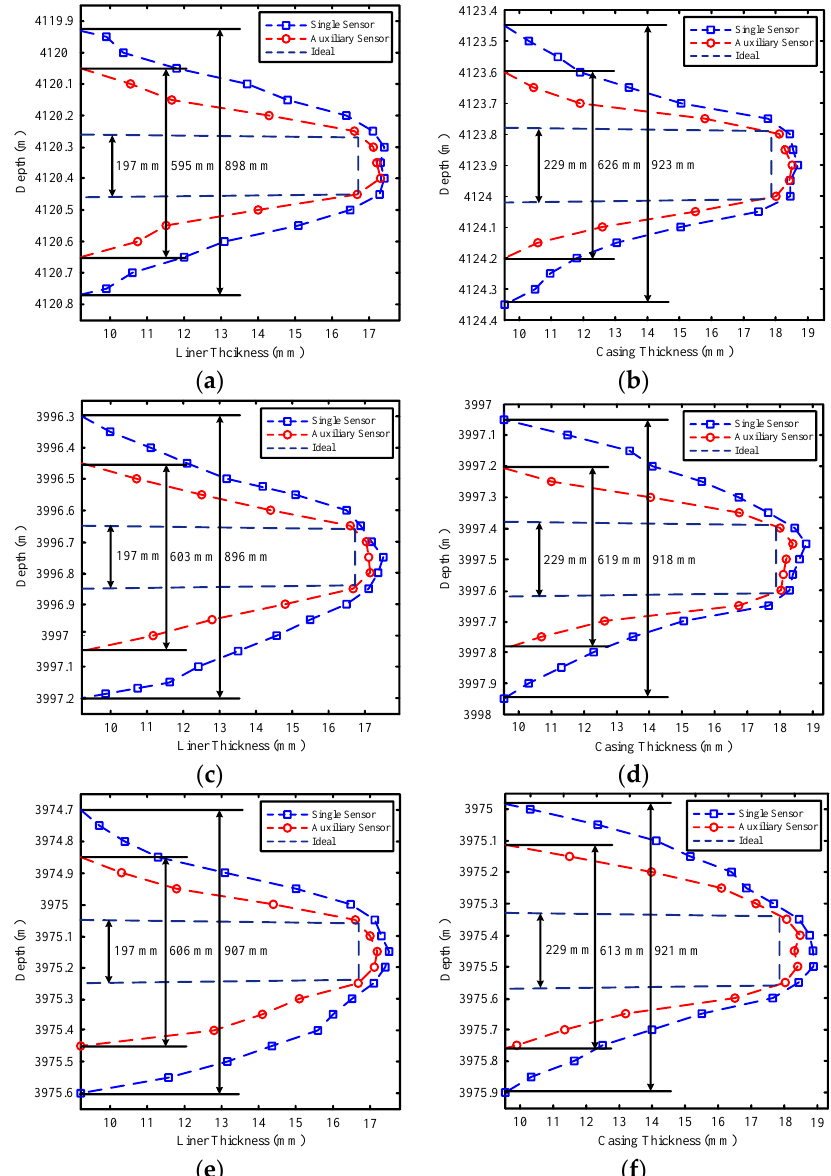
Figure 17. Thickness of the liner and casing with collars: ( a ) liner collar at 4120.36 m; ( b ) casing collar at 4123.9 m; ( c ) liner collar at 3996.75 m; ( d ) casing collar at 3997.5 m; ( e ) liner collar at 3975.15 m; and ( f ) casing collar at 3975.45 m.